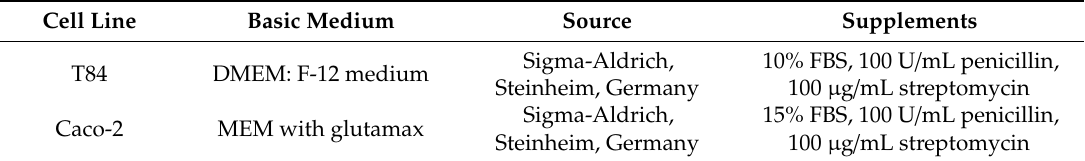
Table 2. Complete growth mediums for di ff erent cell lines.